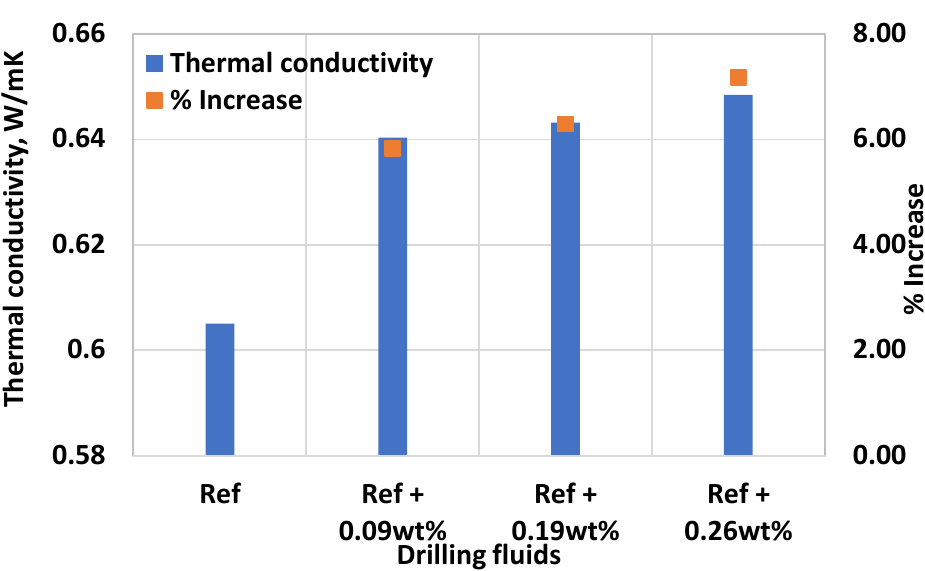
Figure 11. Effect of MoS 2 nanoparticle solution on the heat conductivity of the base fluid.